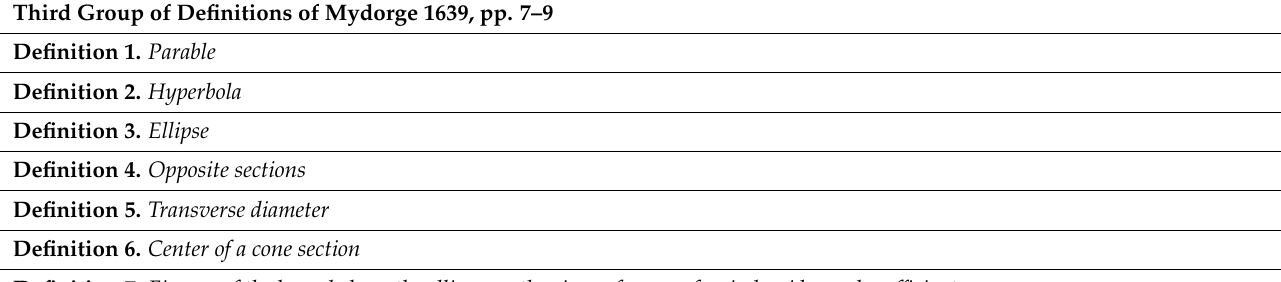
Table 3. The third group of definitions by